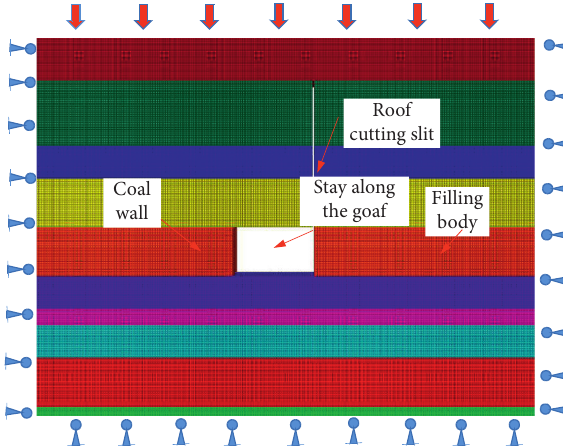
Figure 4: Numerical calculation Table 1: Rock mechanical parameters.